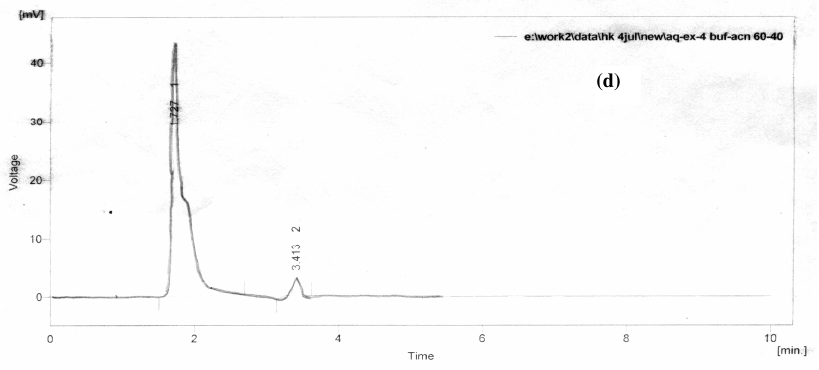
Figure 5. HPLC fingerprint of (a) OSME; (b) OKME; (c) OSAE and (d)